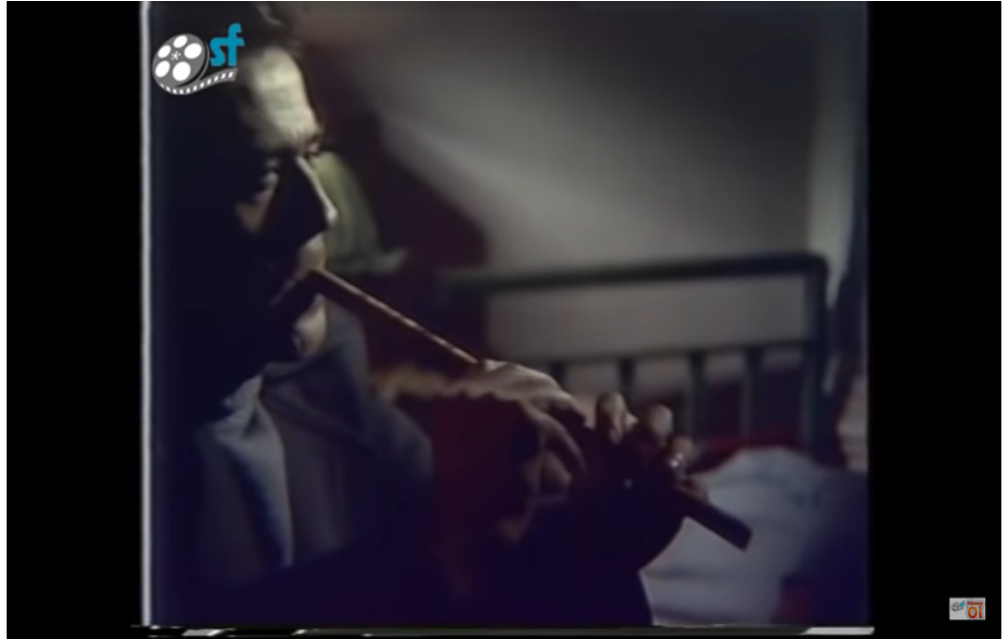
Figure 4- Yavuz playing the “kaval”: The Voice of the